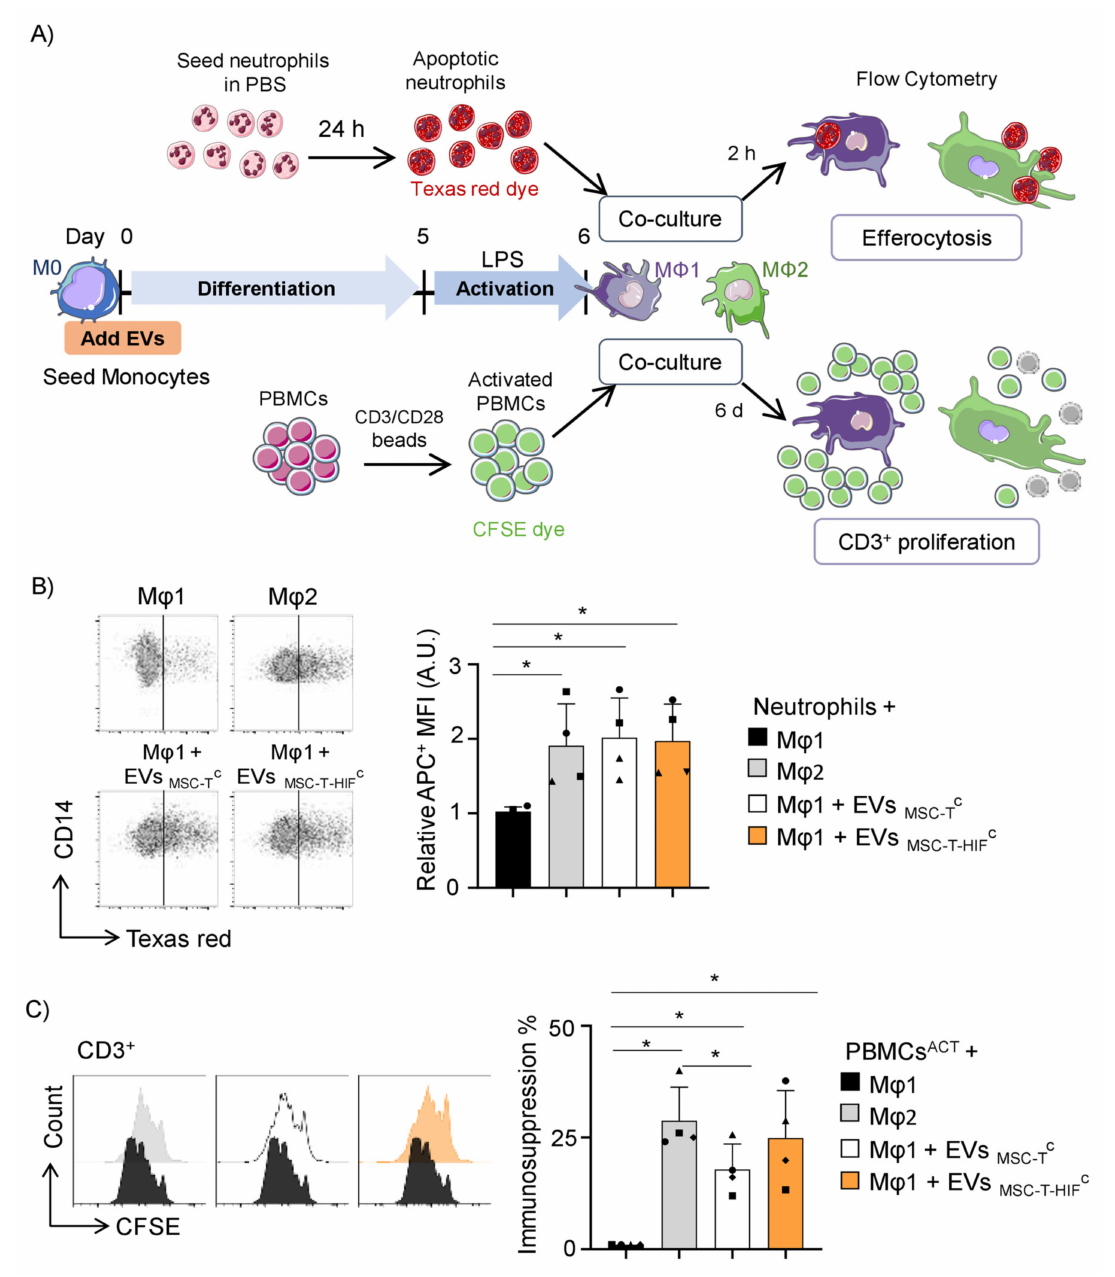
Figure 3. Efferocytic and immunosuppressive capacity of M ϕ treated with EV MSC-T-HIFC . ( A ) Scheme of the in vitro experimental design; ( B ) apoptotic neutrophil internalization was measured by increase in the APC channel and represented as mean fluorescence intensity (MFI) in each condition. Relative MFI was calculated by dividing all individual data by the MFI of M ϕ 1. Graph represents mean ± SD of four independent experiments. One-way ANOVA with Geisser–Greenhouse correction was used for statistical analysis. Representative dot plots are shown. ( C ) Proliferation of T-cells. Peripheral blood mononuclear cells were stained with carboxyfluorescein succinimidyl ester (CFSE) and stimulated with anti-CD3 and anti-CD28 beads before co-culture with differentiated M ϕ 1 treated or not treated with EVs, or with differentiated M ϕ 2. After 5 days, cells were stained with anti-CD3 antibodies and proliferation of T-cells was determined by flow cytometry measurement of CFSE dilution. Suppression (percentage) was calculated based on the expansion index. Graph represents mean ± SD of four independent experiments. One-way ANOVA with Geisser–Greenhouse correction was used for statistical analysis. Each symbol shape ( • , (cid:4) , (cid:78) , (cid:7) ) represents a different paired experiment. * p <